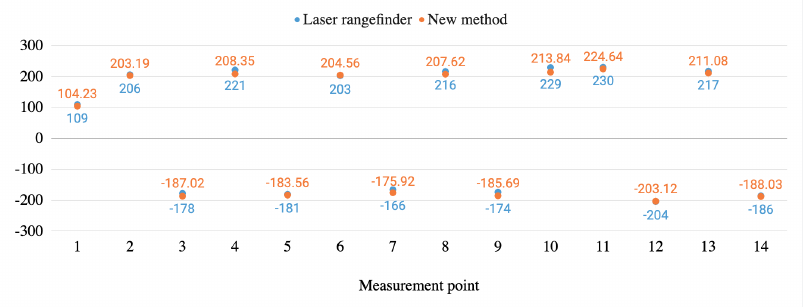
real infrastructure environment.